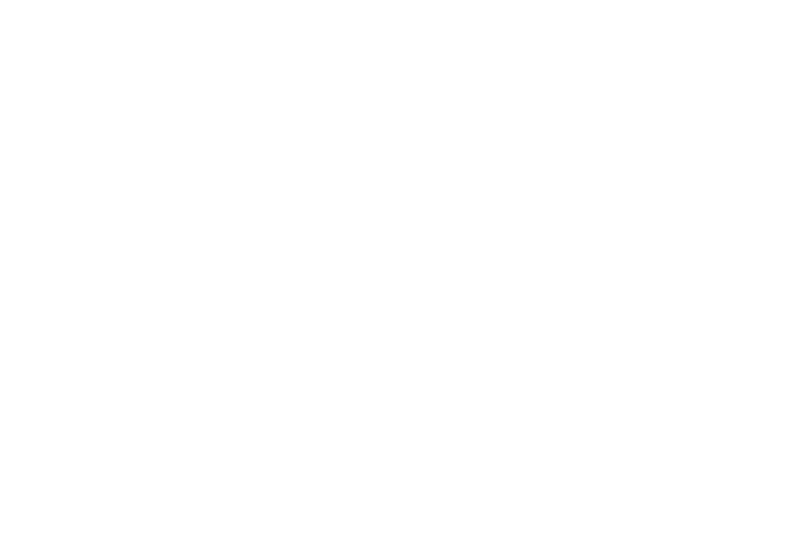
An overview of the metabolism of Thermodesulfovibrio sp. N1 reconstructed from its genome. Enzyme abbreviations: LDH, lactate dehydrogenase; POR, pyruvate ferredoxin oxidoreductase; ACS, acetyl-CoA synthetase; Tsr, thiosulfate reductase (subunits A, B, and C); Dsr, dissimilatory sulfite reductase; Apr, adenosine-5′-phosphosulfate reductase; QmoABC, adenylylsulfate reductase-associated electron transfer complex; Sat, sulfate adenylyltransferase; PPase, pyrophosphatase; FdhAB, periplasmic formate dehydrogenase; Hmc, membrane-linked Hmc complex; Nrf, cytochrome c nitrite reductase; Nuo, membrane-linked complex comprising subunits NuoA, B, C, D, H, I, J, K, L, M, and N of NADH-ubiquinone oxidoreductase; HdrABC, heterodisulfide reductase subunits A, B, and C; MvhADG, methyl viologen-reducing hydrogenase subunits A, D, and G; Hase 1, periplasmic group 1 [NiFe] uptake hydrogenase; Hase 3, cytoplasmic group 3b [NiFe] bidirectional hydrogenase; Hyf, membrane-linked group 4 [NiFe] hydrogenase; PsrAB, subunits A and B of Psr/Psh family oxidoreductase; ATP, F1F0 ATP synthase; Mnh, a multisubunit Na+/H+ antiporter of the Mnh family (MnhBCDEFG); BcsABZC, cellulose synthase. Other abbreviations: ox/red, oxidized and reduced forms; cyt, cytochrome c; Pi, phosphate; PPi, pyrophosphate; CoA, coenzyme A; OM, outer membrane; CM, cytoplasmic membrane.